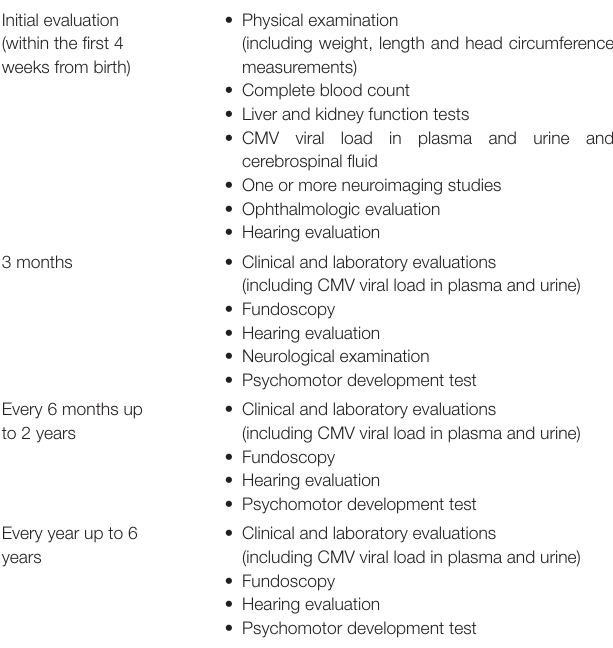
TABLE 1 | Clinical and instrumental